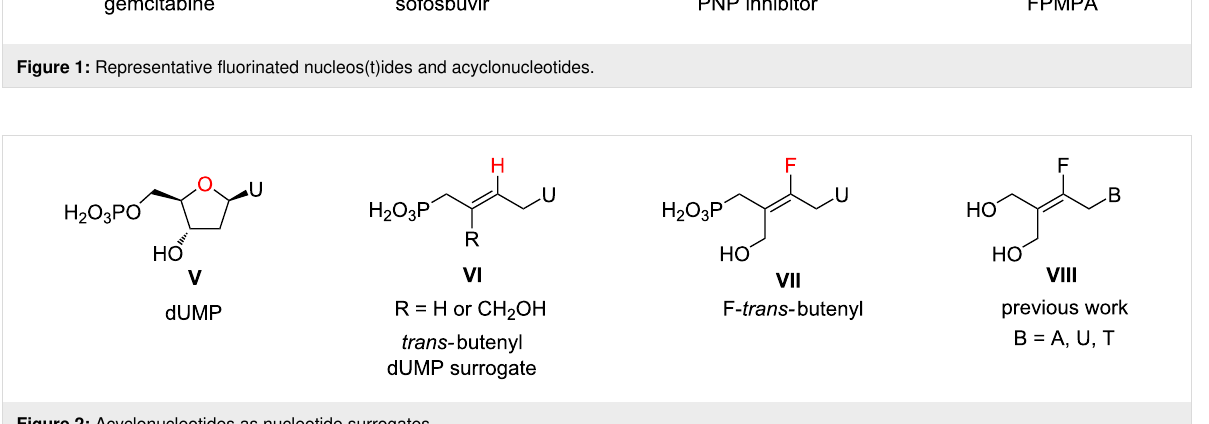
Figure 2: Acyclonucleotides as nucleotide surrogates.